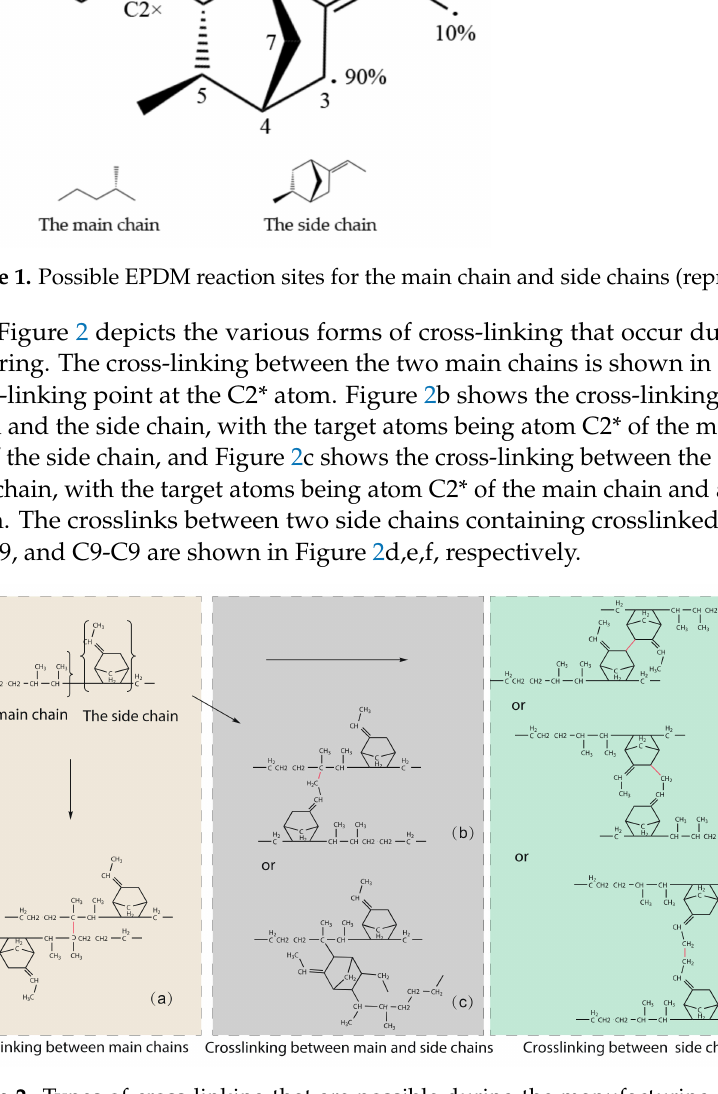
Figure 2. Types of cross-linking that are possible during the manufacturing of EPDM, where the cross-linking interaction is distinguished in red color. ( a ) is the C2*-C2* crosslinking, ( b ) is the C2*-C9 crosslinking, ( c ) is the C2*-C3 crosslinking, ( d ) is the C3-C3 crosslinking, ( e ) is the C3-C9 crosslinking, ( f ) is the C9-C9